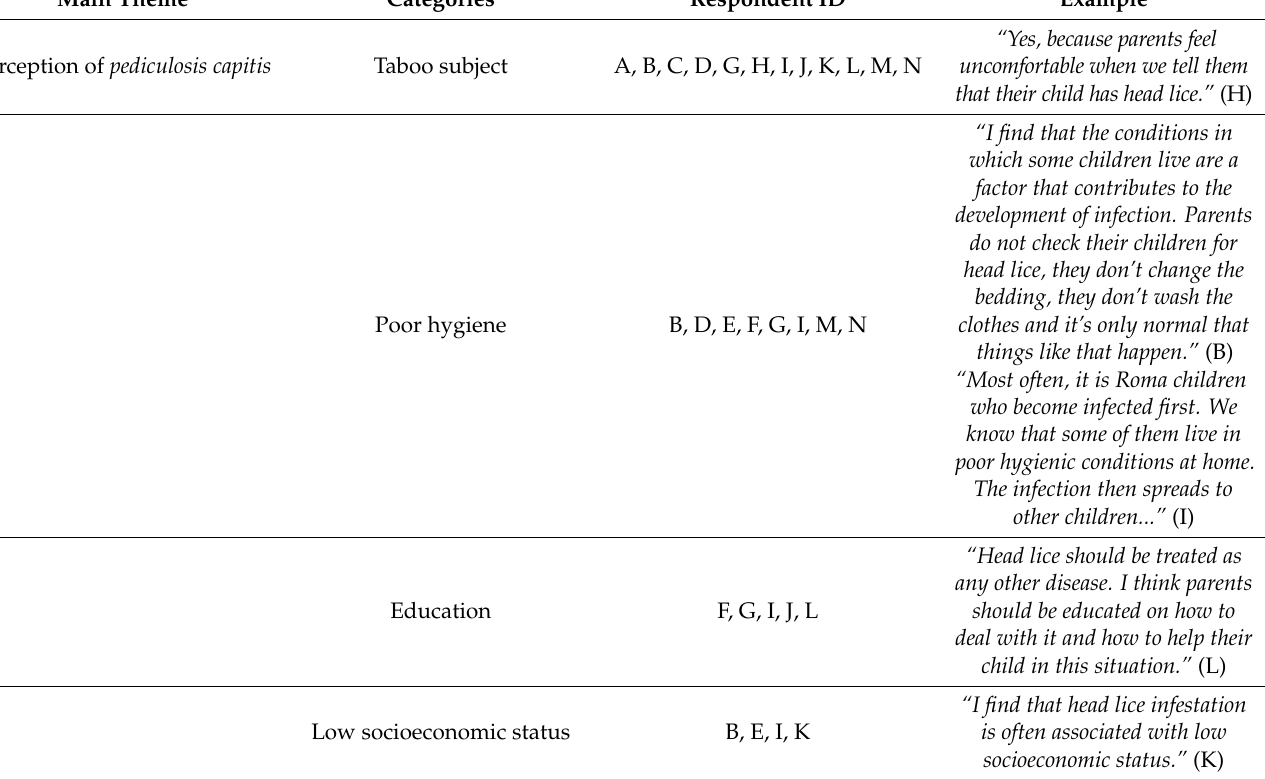
Table 7. Thematic analysis of categories and verbatim quotes for theme five: “ Perception of pediculosis capitis ”. Main